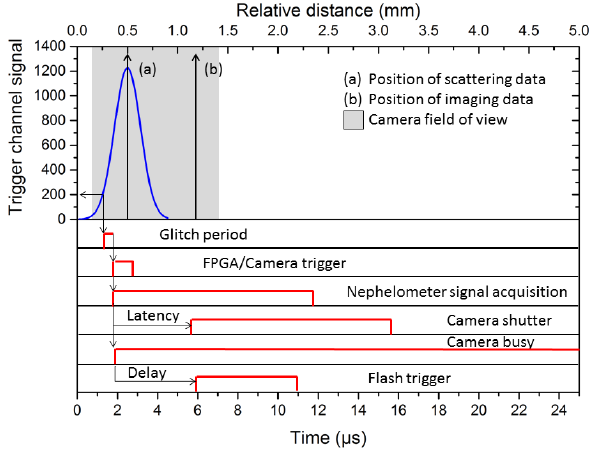
Figure 4. Signal detection and processing scheme for a valid par- ticle event at a typical airspeed of 200ms − 1 and at an assumed trigger threshold of 200. The relative distance along the particle tra- jectory, i.e. the instrument axis, is given on the upper axis. Note, that due to the camera field of view of 1.27mm along the instru- ment axis, the imaging system can be aligned in the laboratory by using test particles with particle speeds of only a few metres per second.